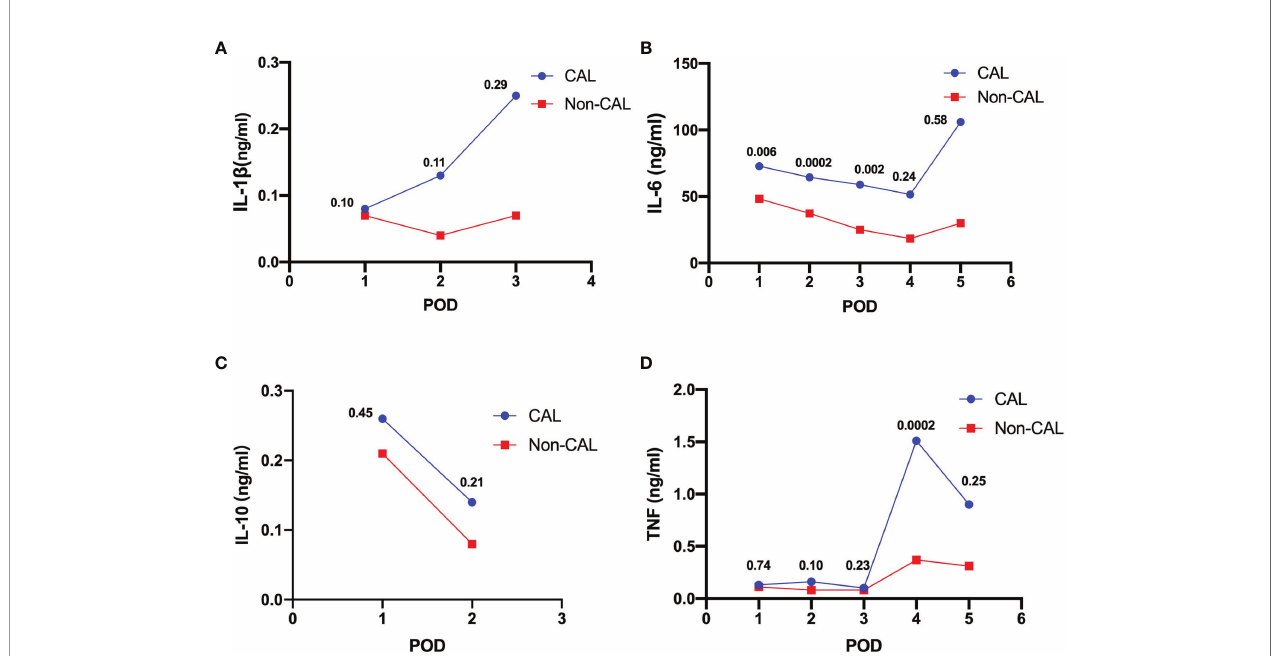
FIGURE 2 | Weighted means of peritoneal levels of IL-1 b ( A , ng/mL), IL-6 ( B , ng/mL), IL-10 ( C , ng/mL) and TNF ( D , ng/mL) on patients with CAL and non-CAL patients each postoperative day. The P values of statistical signi fi cance are marked when